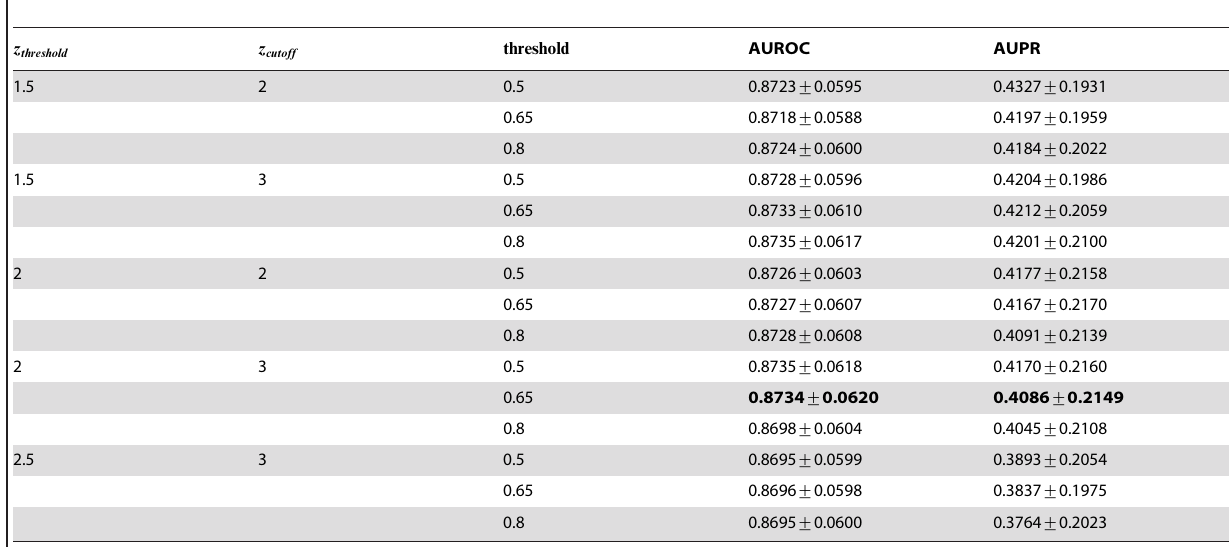
Table 8. Effects of z cutoff , z threshold and the preprocessing threshold of (cid:2) GG 6 0 on AUROC and AUPR of TRaCE in DREAM4 100-gene subchallenge: single- and double-gene KO